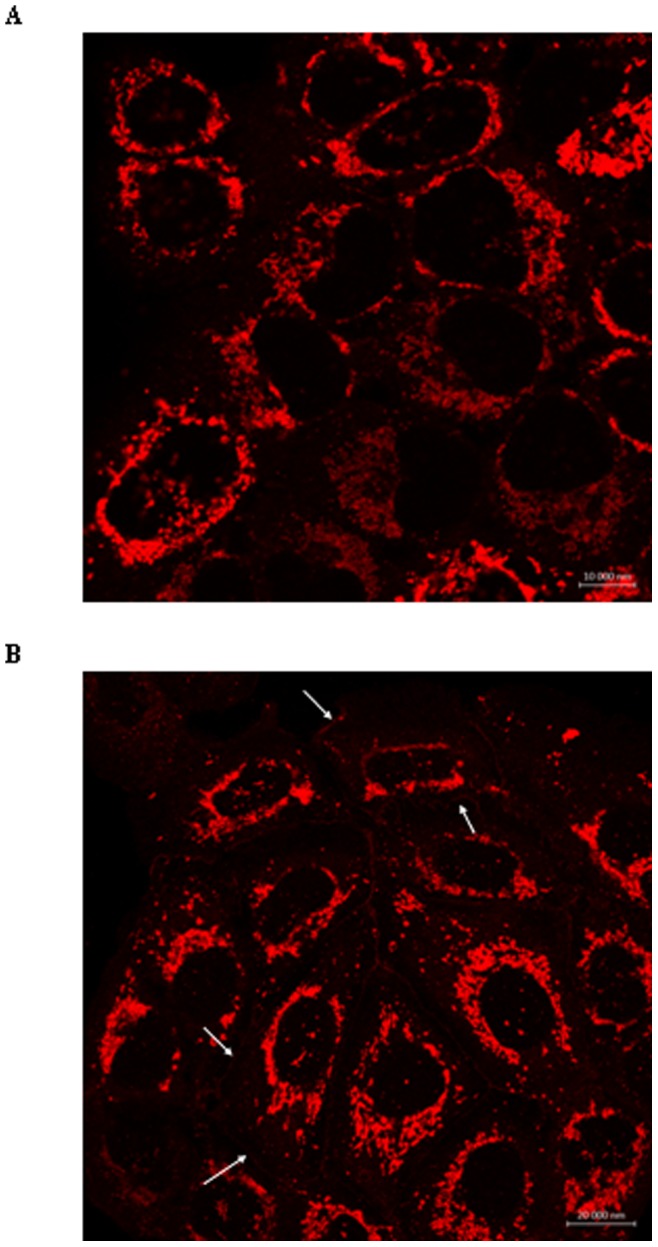
Immunolocalization of CFTR in CFBE41o−/F508del cells after GnRH treatment.A. Representative confocal photomicrographs of the localization of F508del-CFTR in cells without any treatment. CFTR is likely observed around the nuclei, in the endpoplasmic reticulum. B. Representative confocal photomicrographs of the localization of F508del-CFTR in cells after GnRH treatment. CFTR is likely observed in the endpoplasmic reticulum but also in membranes.